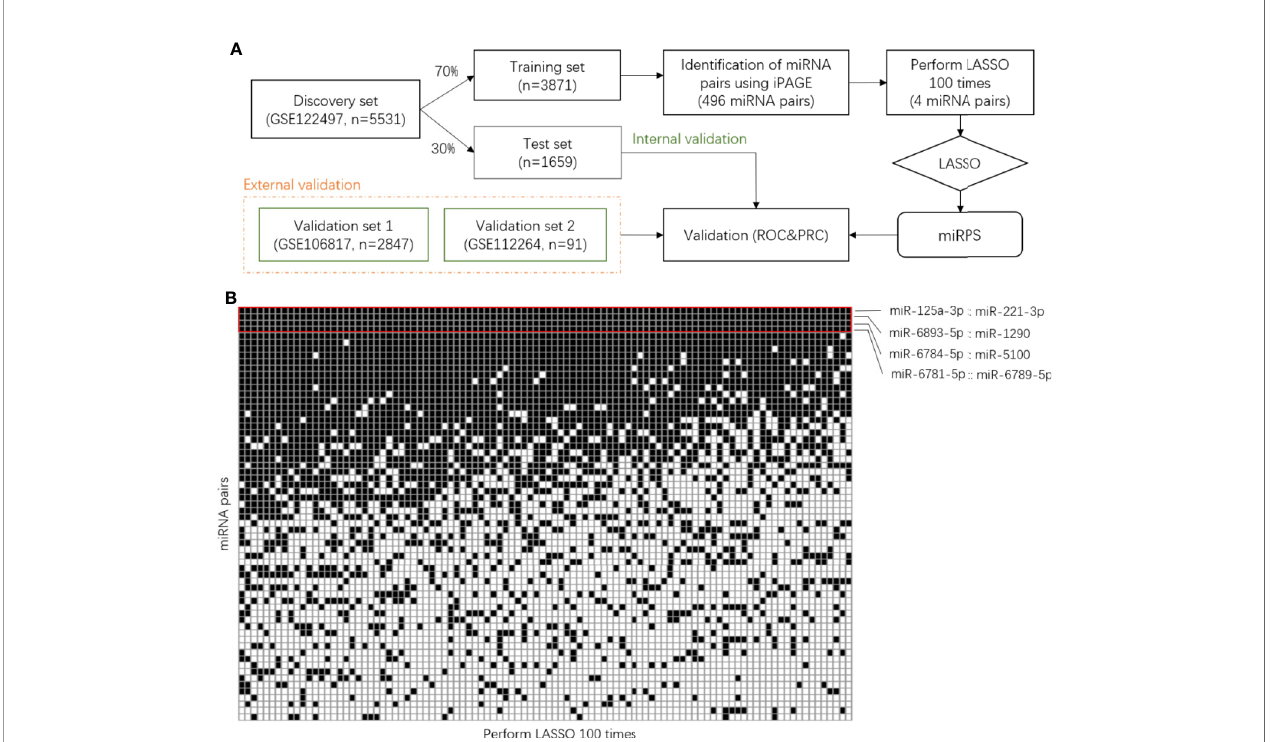
FIGURE 1 | Identi fi cation of miRNA pair signature. (A) Work fl ow of this study. (B) Binary matrix with rows represent miRNA pairs and columns represent the result of LASSO. The black grid corresponds to the selected pairs. iPAGE, individualized Pair Analysis of Gene Expression. LASSO, Least absolute shrinkage and selection